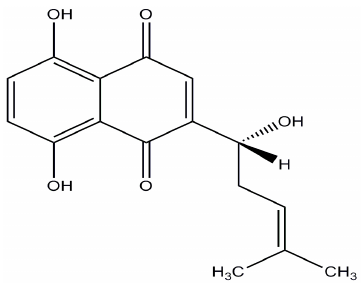
Figure 1. The structure of shikonin (C 16 H 16 O 5 ; molecular weight: 288.30).